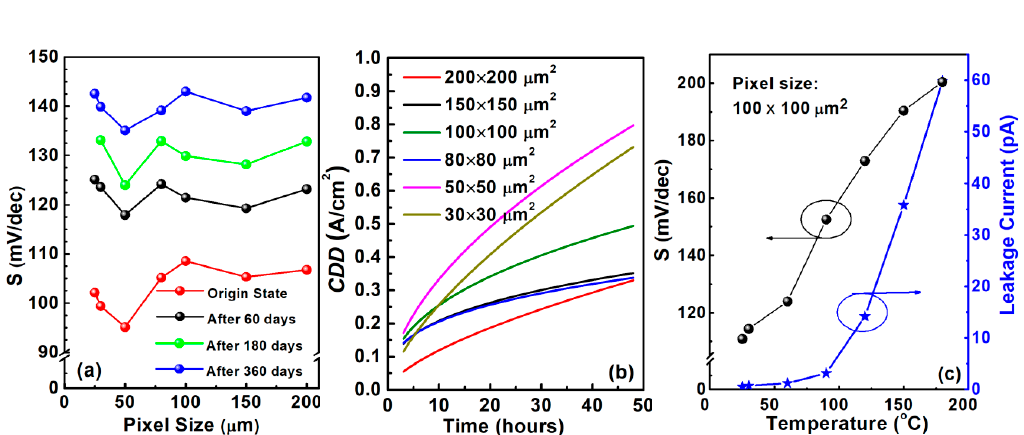
Figure 5. ( a ) Slope degradation trend of micro-LEDs as aging increases; ( b ) current density deviation trend at 3 V at 85 °C and 85% relative humility; ( c ) S and leakage current performance under different temperatures.